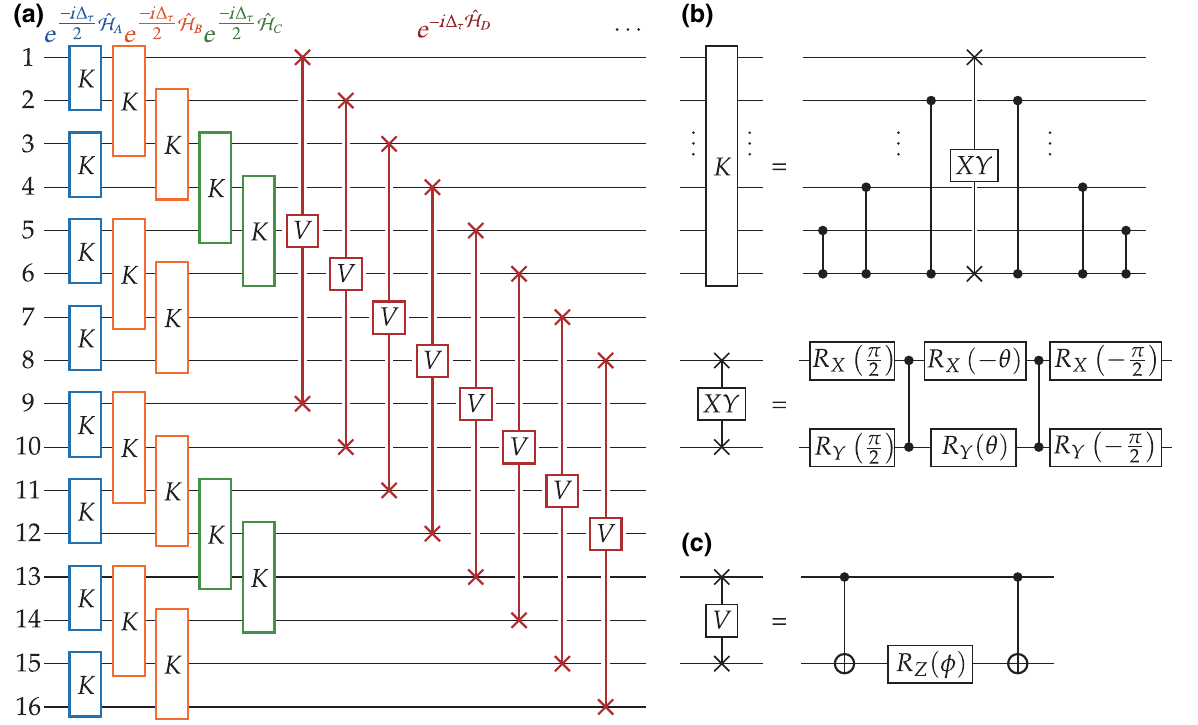
ˆ S 2 ((cid:3) τ ) in Eq. (B3) for the